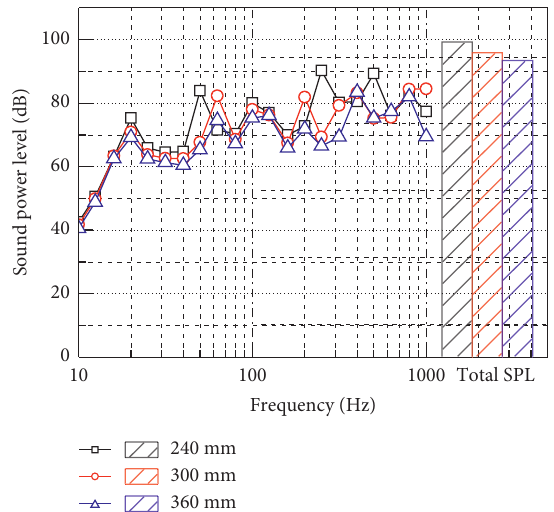
Figure 9: Variation of the sound power level in terms of the thickness of the concrete